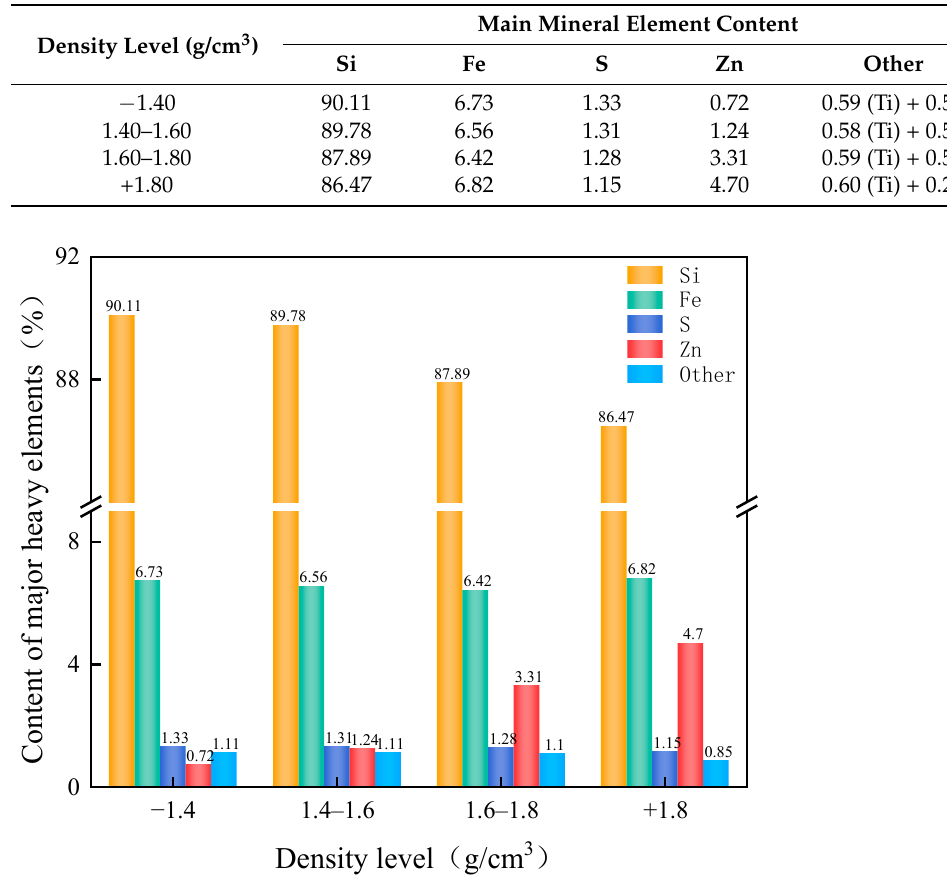
Figure 5. Main elements content of mineral-enrichment area.